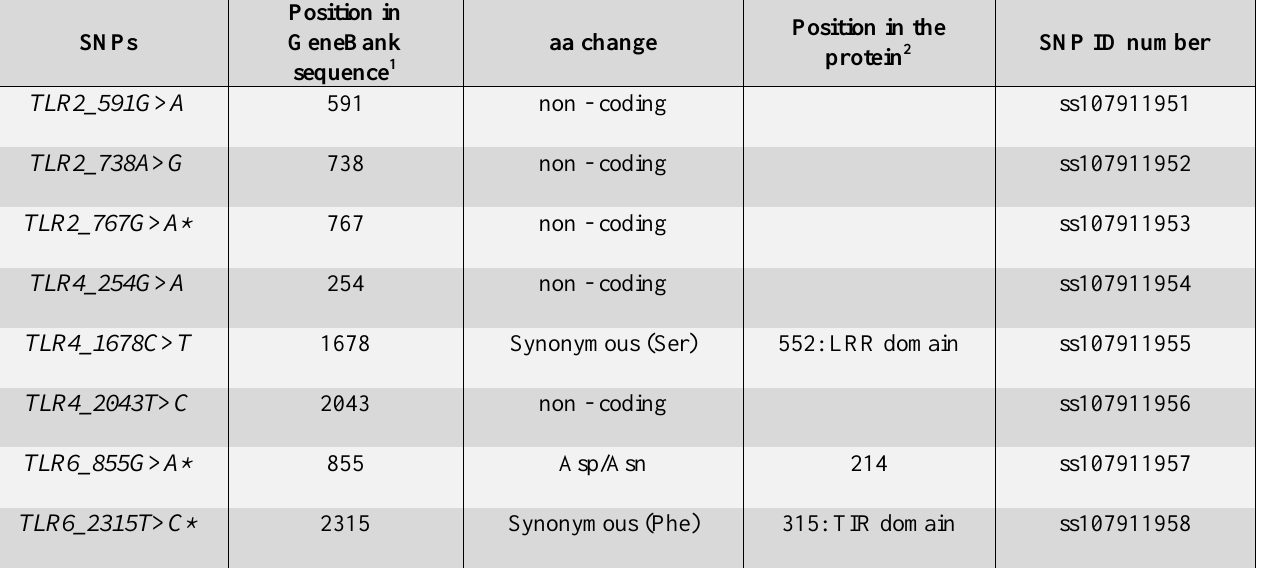
Position in the SNP ID number protein 2